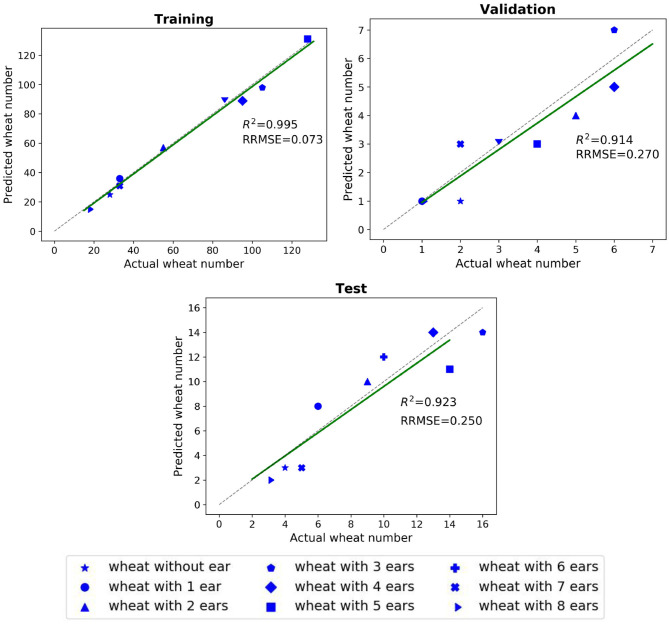
Comparison between the counted wheat samples with different ear numbers predicted by the Pattern-Net (vertical axis) and the ground-truth values (horizontal axis). We used MeshLab for collecting the ground-truth measurements in this experiment. The training, validation, and test experiments contain 580, 30, and 80 3D models with 1,024 points, respectively.